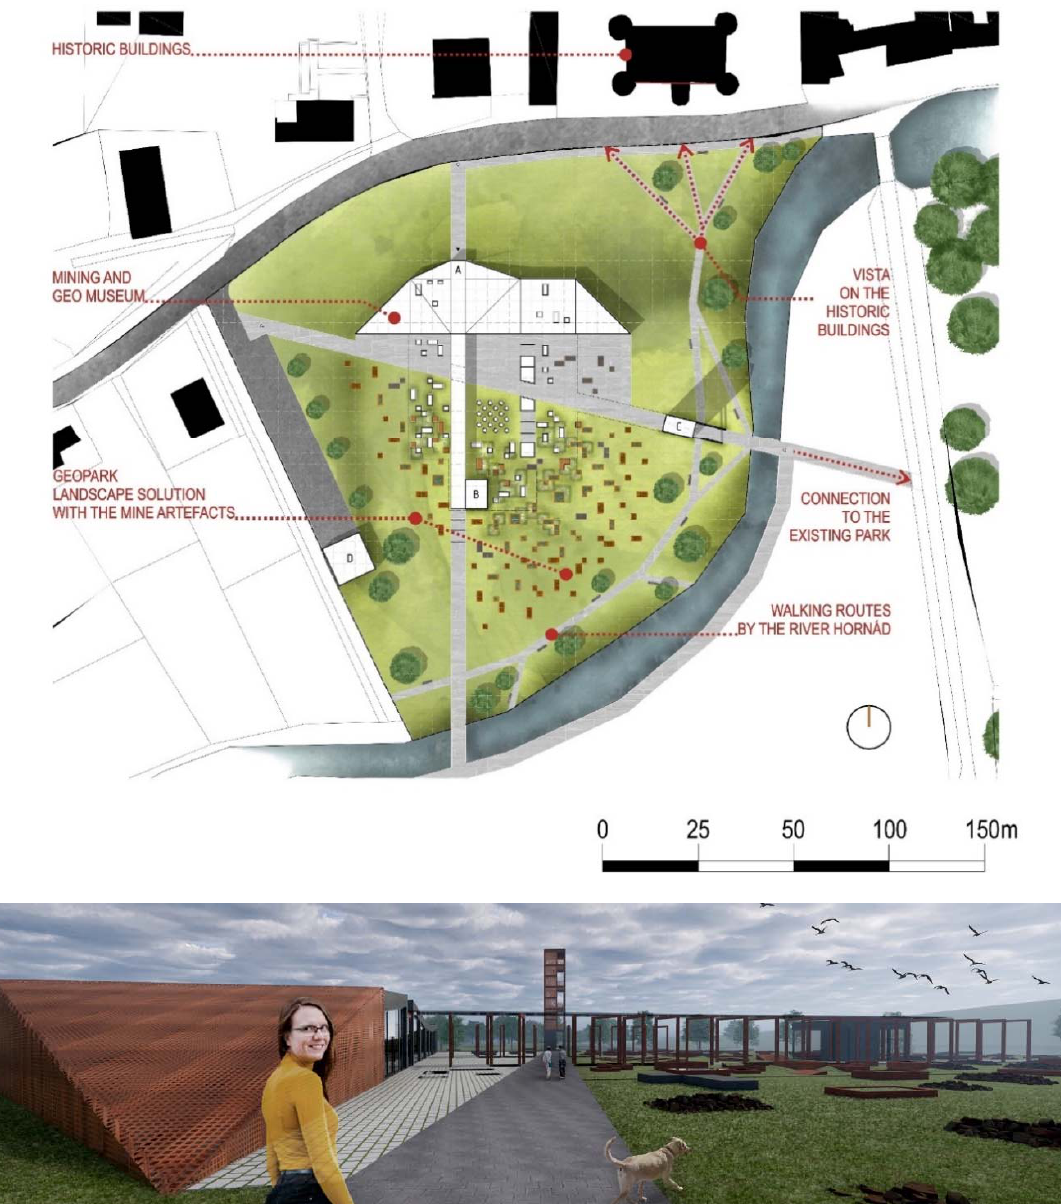
Figure 13. The concept highlights mining and the landscape, Case Study 2b—situation and visualization (author´s design studio, V. Volková).